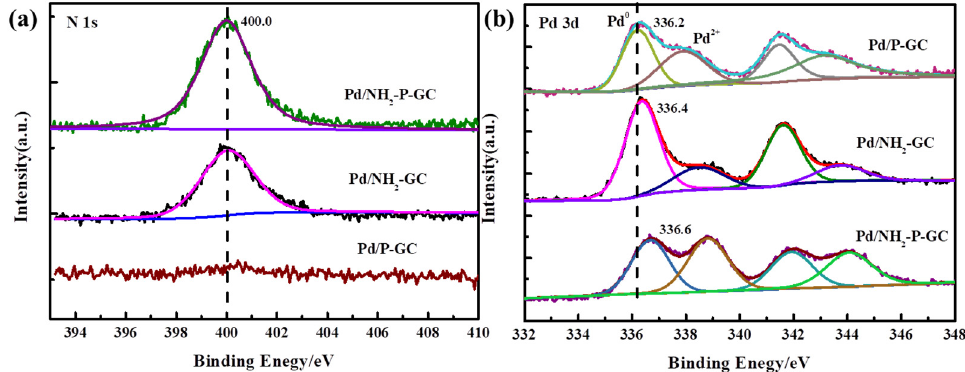
Figure 5. High-resolution XPS spectra of ( a ) N 1s and ( b ) Pd 3d in Pd/NH 2 -GC, Pd/NH 2 -P-GC and used Pd/NH 2 -P-GC. used Pd/NH 2